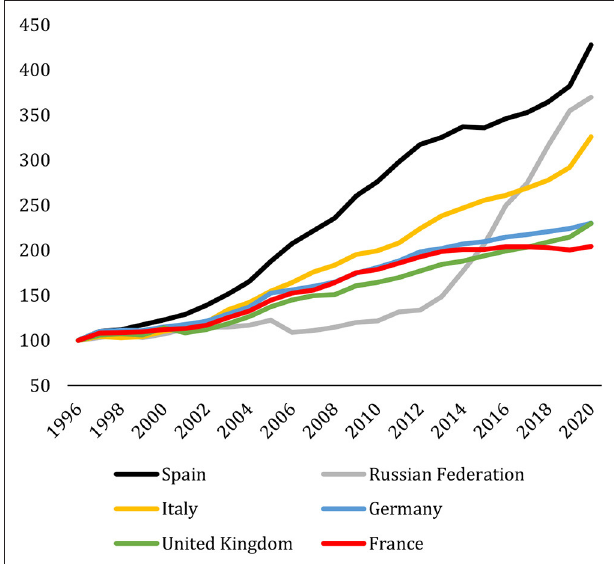
FIGURE 5 | Scientific production (number of documents) of the first European countries in the 2020 world ranking. 1996–2020. 1996 = 100. Scopus.